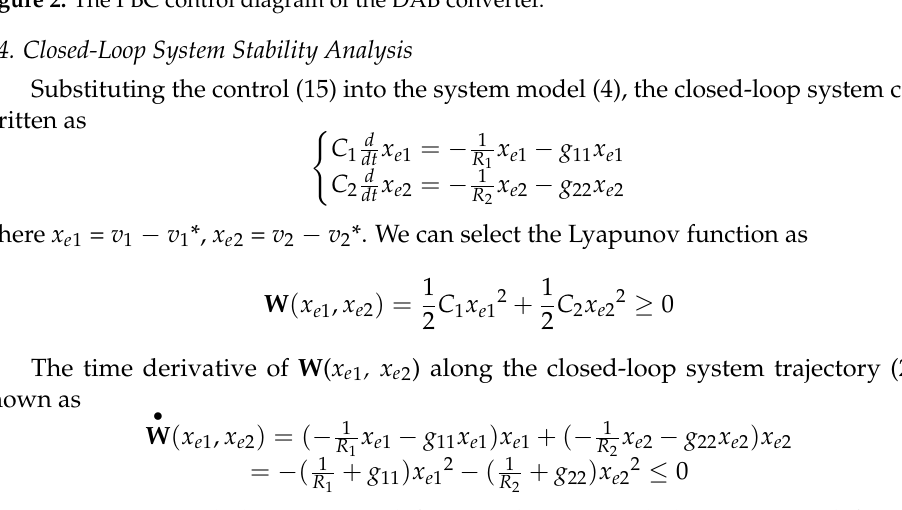
Figure 2. The PBC control diagram of the DAB converter.